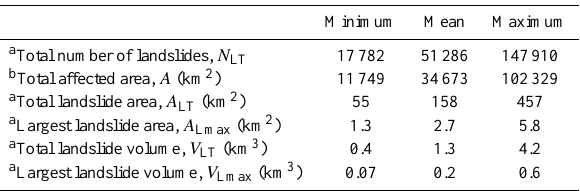
Table 4. Summary of landslide variables calculated from formulae by Keefer and Wilson (1989) and Malamud et al. (2004) following a M w = 8 . 0 earthquake on the Alpine